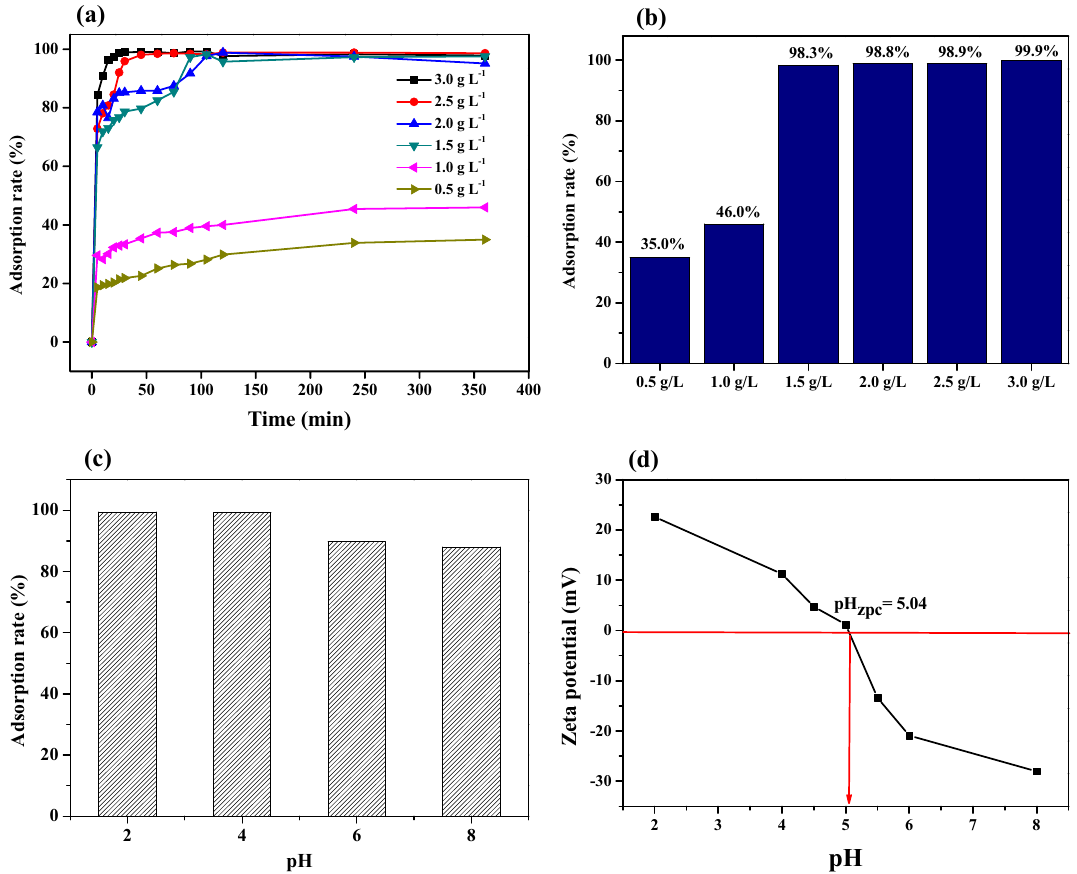
Figure 3. ( a ), ( b ) Effect of dosage on Pt(IV) adsorption capacities, ( c ) effect of pH on Pt(IV) adsorption and ( d ) zeta potential of